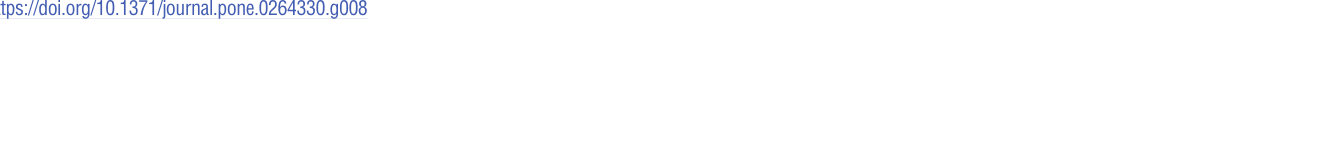
PLOS ONE | https://doi.org/10.1371/journal.pone.0264330 March 16,